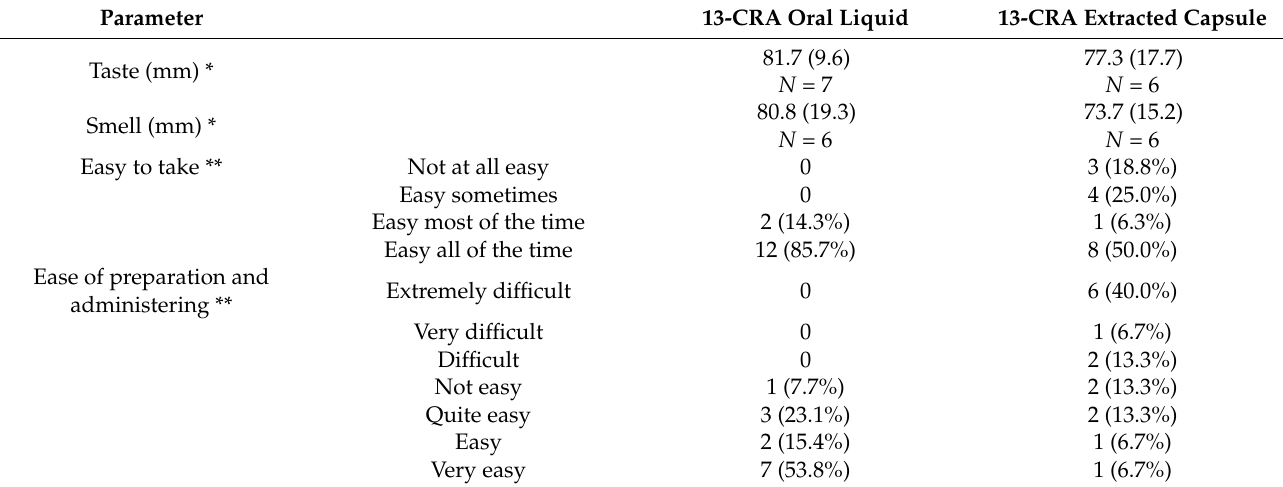
Table 3. Palatability and